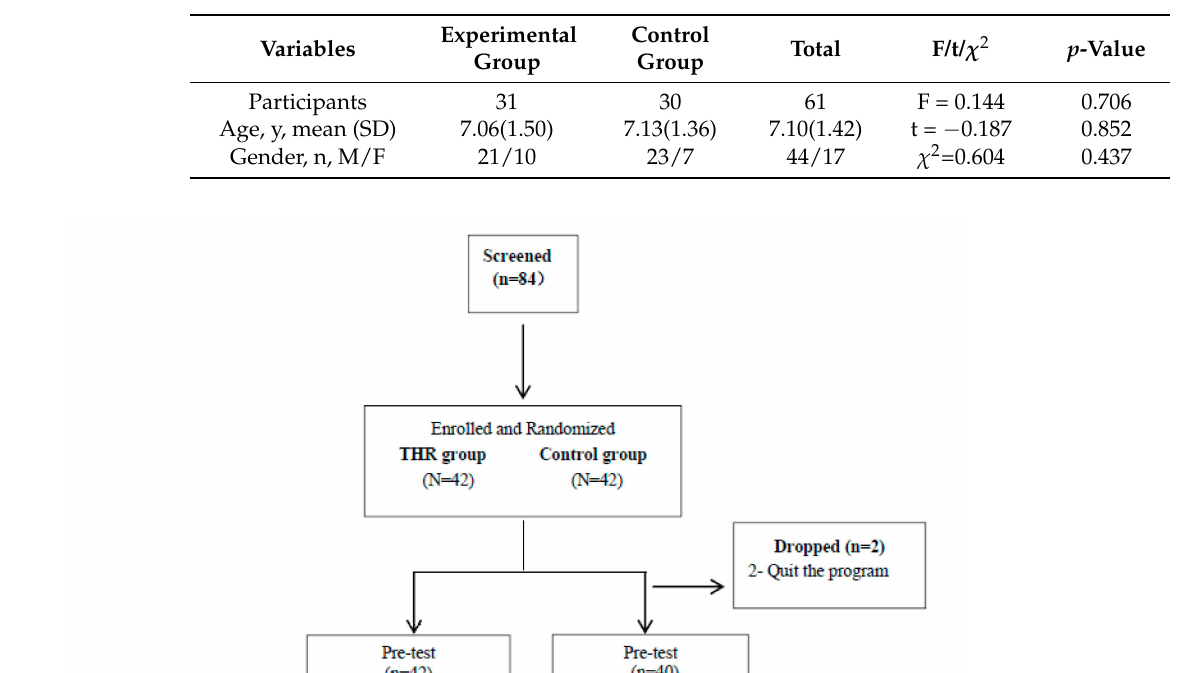
Table 1. The demographic data of the participants.